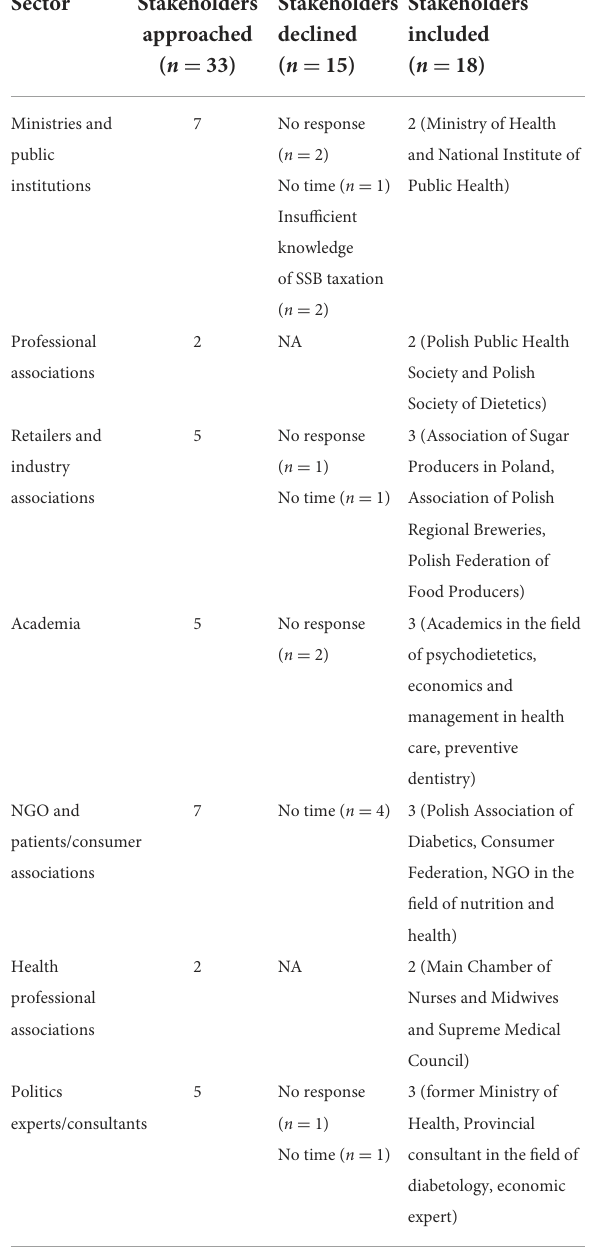
TABLE 1 Recruitment of